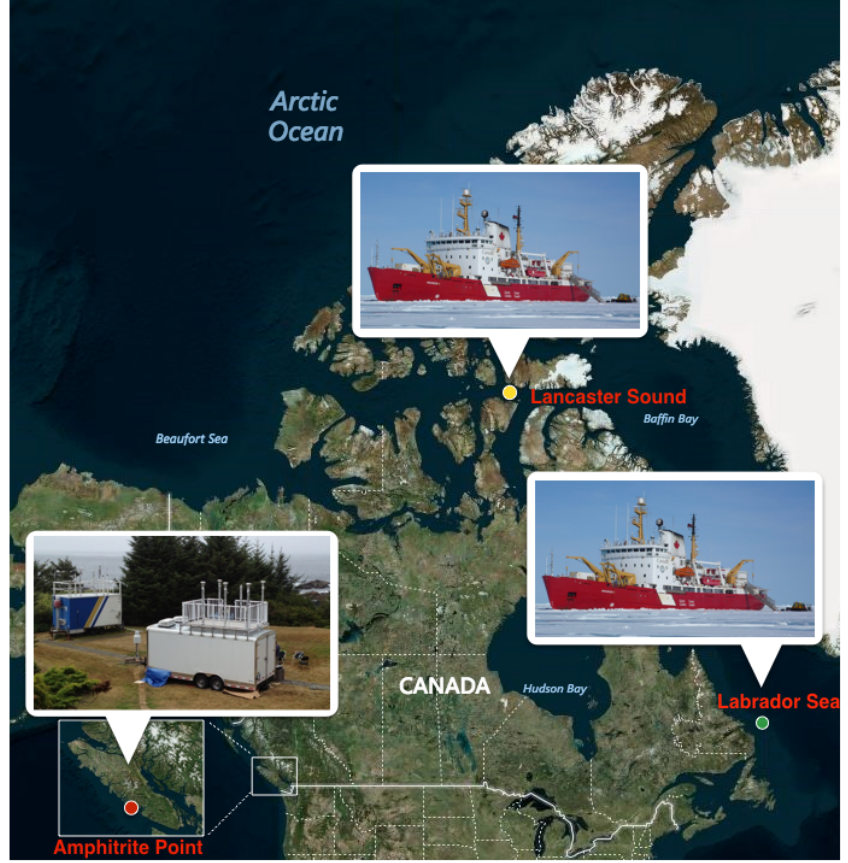
Figure 1. Map showing the three sampling locations: Amphitrite Point (red dot), Labrador Sea (green dot), and Lancaster Sound (yellow dot). Inserts show the images of the sampling platform used at each